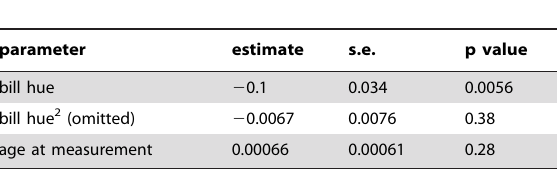
Table 2. Proportional hazard model within